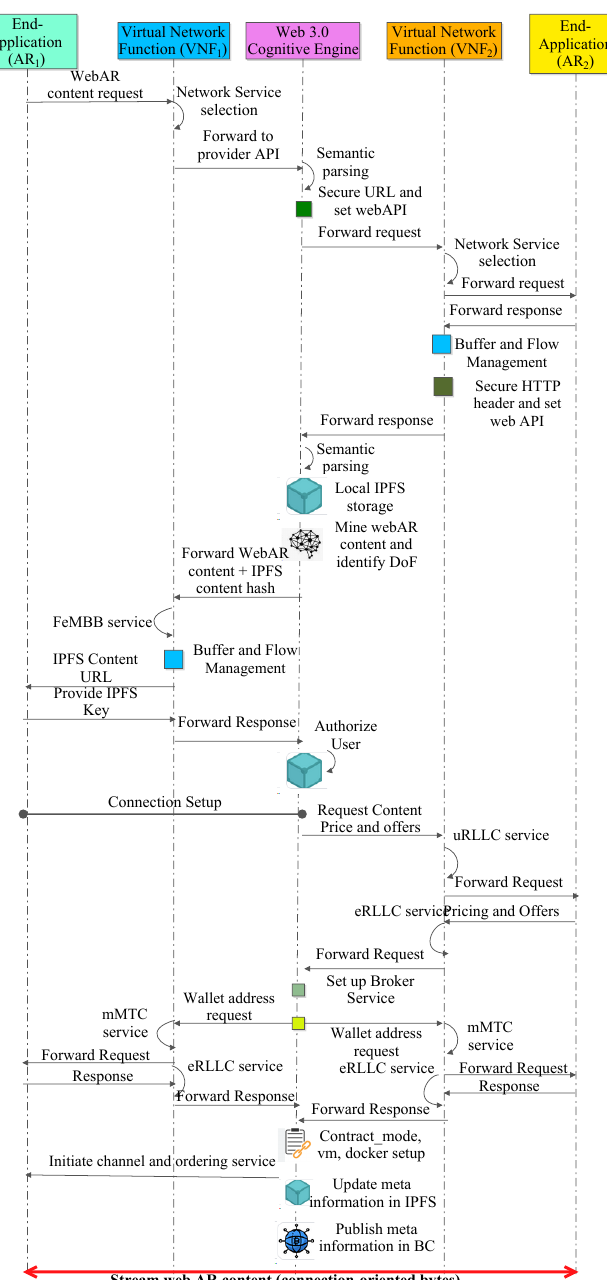
Figure 5. Interaction sequences between users and entities in the proposed